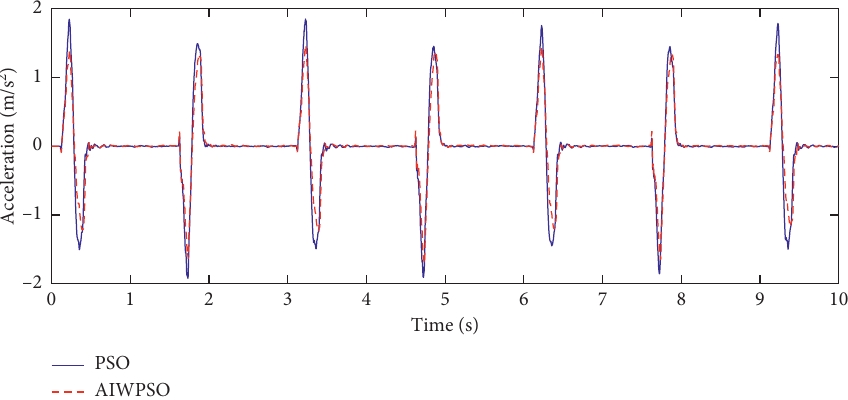
Figure 18: Acceleration of the vehicle body for a trapezoidal profile.